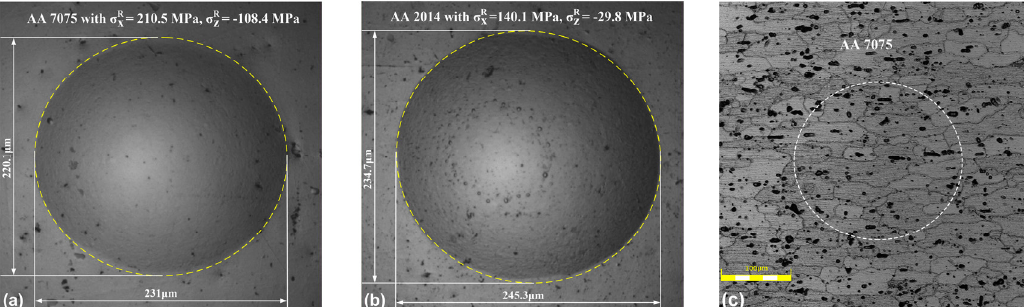
Figure 9. The average load-depth curves for spherical indentations on (a) AA 7075 and (b) AA 2014 with various residual stresses.